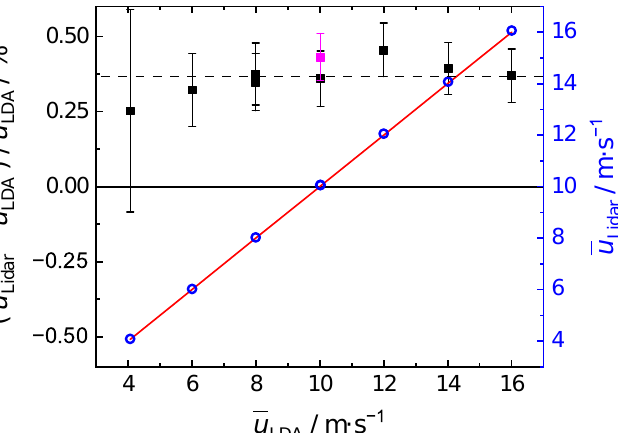
Figure 10. Results of the 2018 comparative measurement between the PTB bistatic lidar and an LDA in the wind tunnel at PTB’s Competence Center for Wind Energy, showing an average deviation of 0.37% between both devices. In order to verify that the PTB bistatic lidar is free of any angular dependence, an additional sample was recorded at 10 m · s − 1 (shown in pink) after the PTB bistatic lidar trailer was rotated 90 ◦